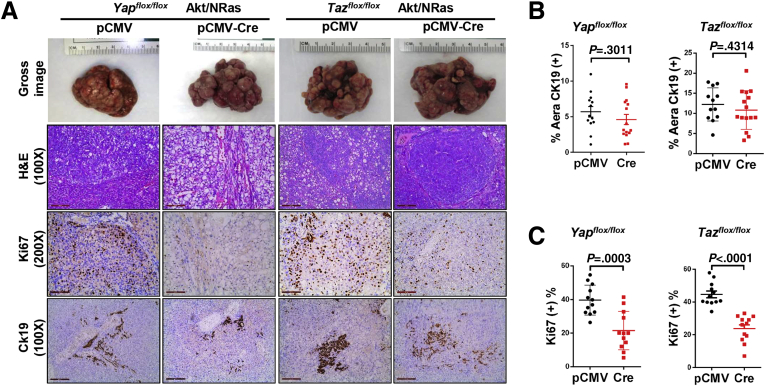
Tumor features in Yap or Taz-depleted Akt/NRas murine livers. (A) Representative images of gross images, H&E staining, and immunohistochemistry for Ki67 and cytokeratin 19 (Ck19). Scalebar: 200 μm for magnification of 100×, 100 μm for magnification of 200×. (B) Percentages of Ck19-positive area in the 2 groups. (C) Percentage of Ki67-positive cells in tumors.